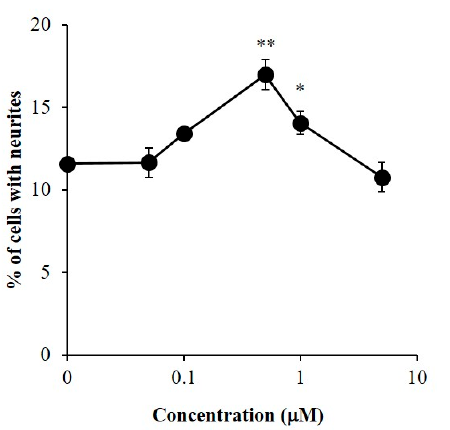
Figure 5. Neurite outgrowth-promoting activity of β -sitosterol in the presence of NGF in PC12 cells. PC12 cells were plated at 2.0 × 10 3 cells / well and cultured with the samples at 0.05–5 µ M in the presence of 10 ng / mL of NGF. The extent of neurite outgrowth was measured at 48 h and is expressed as the mean percentage of 300–400 cells. The data represent means ± SD from three independent experiments. * p < 0.05, ** p < 0.01 (Dunnett’s test) as compared with control (10 ng / mL of NGF only).